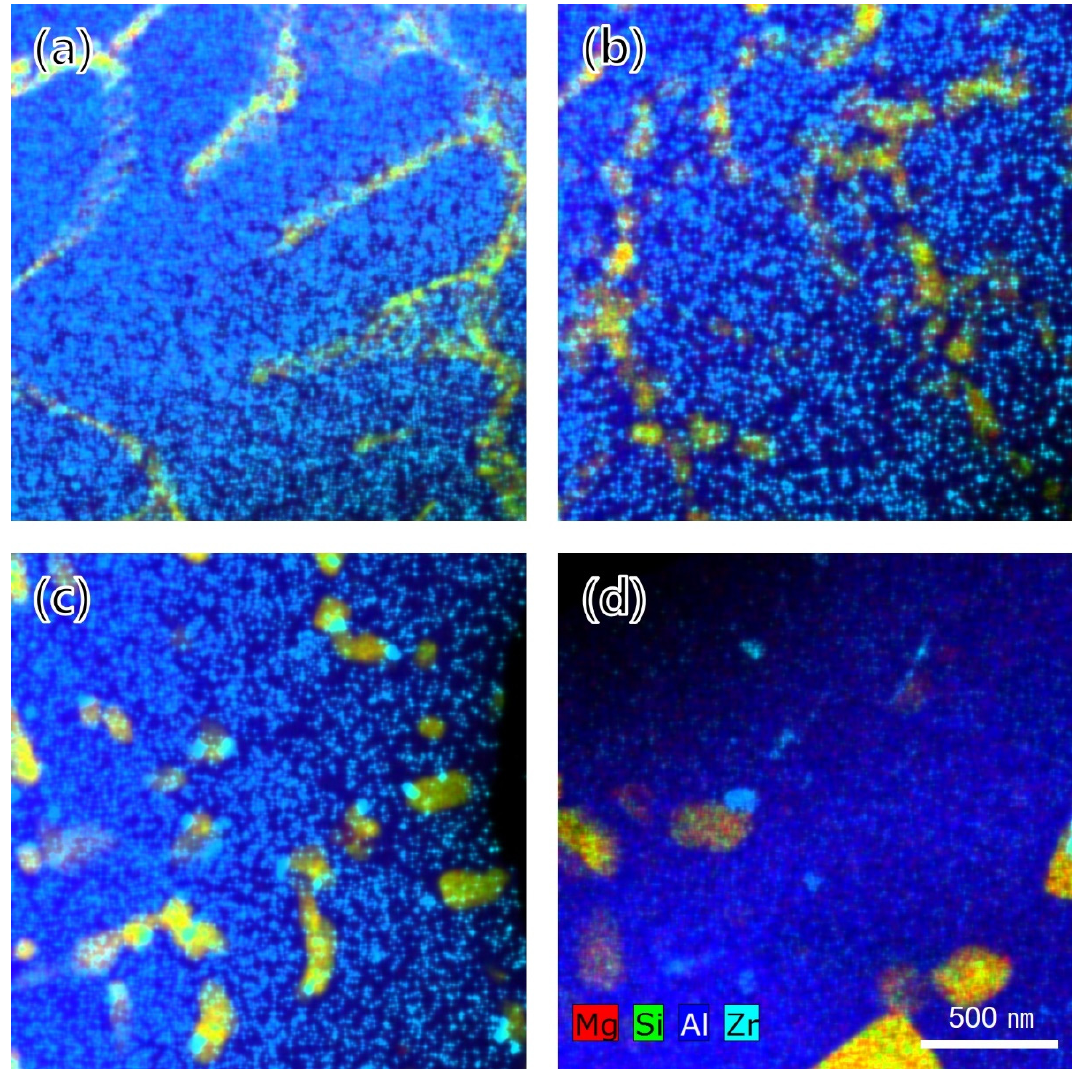
Figure 11. TEM-EDS chemical maps in the coarse-grain region: ( a ) as-built, ( b ) HT1, ( c ) HT2, and ( d ) HT3 conditions.